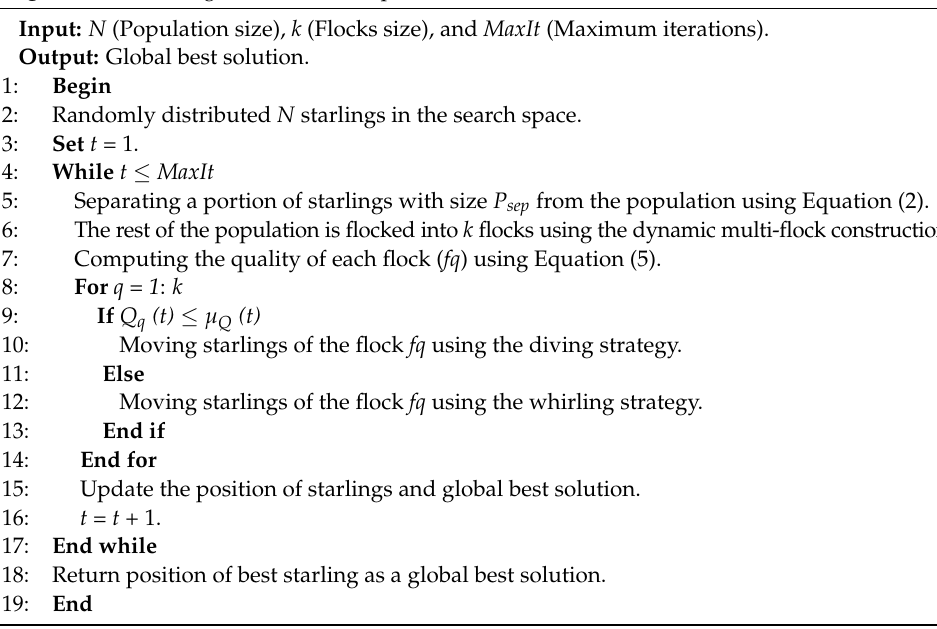
Algorithm 1: Starling Murmuration Optimizer